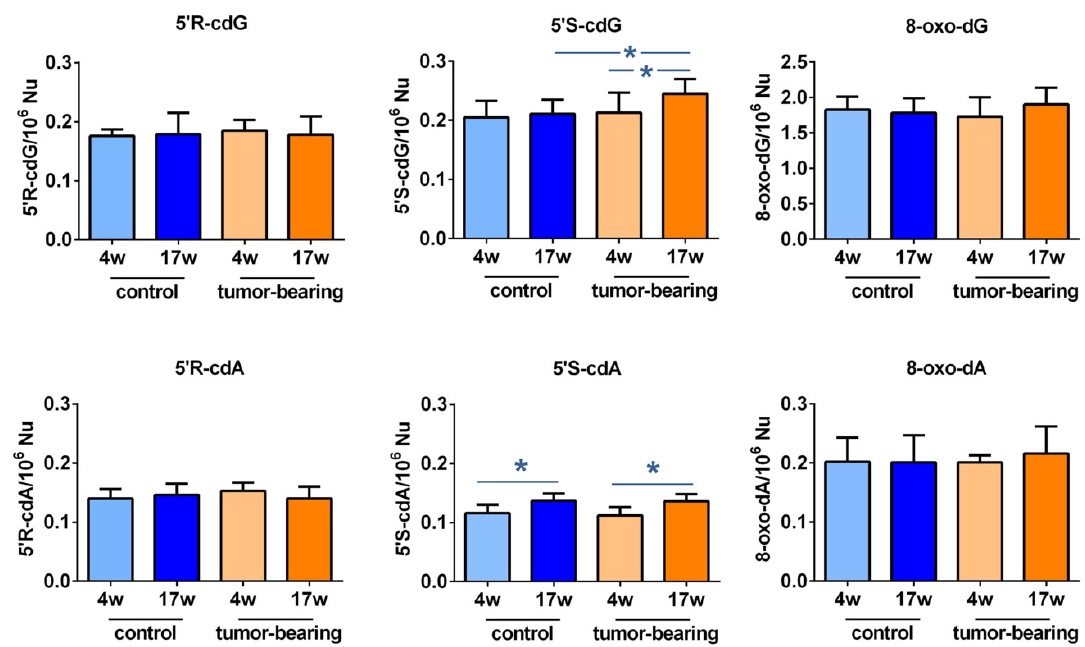
Figure 3. Purine DNA lesions in the brain of SCID mice: the levels (lesions/10 6 nucleosides) of 5 ′ R -cdG, 5 ′ S -cdG, 5 ′ R -cdA, 5 ′ S -cdA, 8-oxo-dG, and 8-oxo-dA in the brain tissue of control SCID and tumor-bearing SCID mice. For specific values, see Tables S1 and S2. The values are given as mean ± SD ( n = 6); * ( p < 0.05).